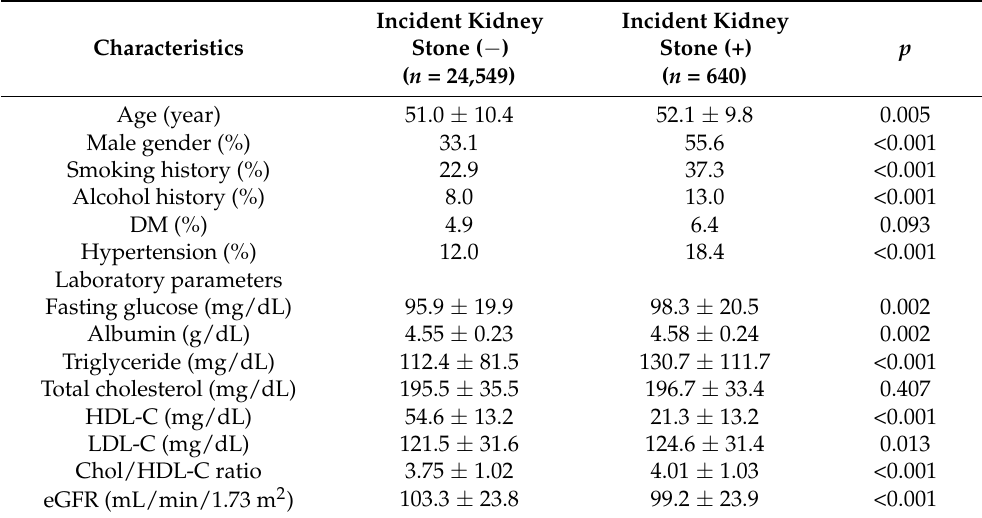
Table 3. Comparison of clinical characteristics among participants according to incident kidney stone disease in study participants without baseline kidney stone disease ( n = 25,189). Incident Kidney Characteristics Stone ( − ) ( n =